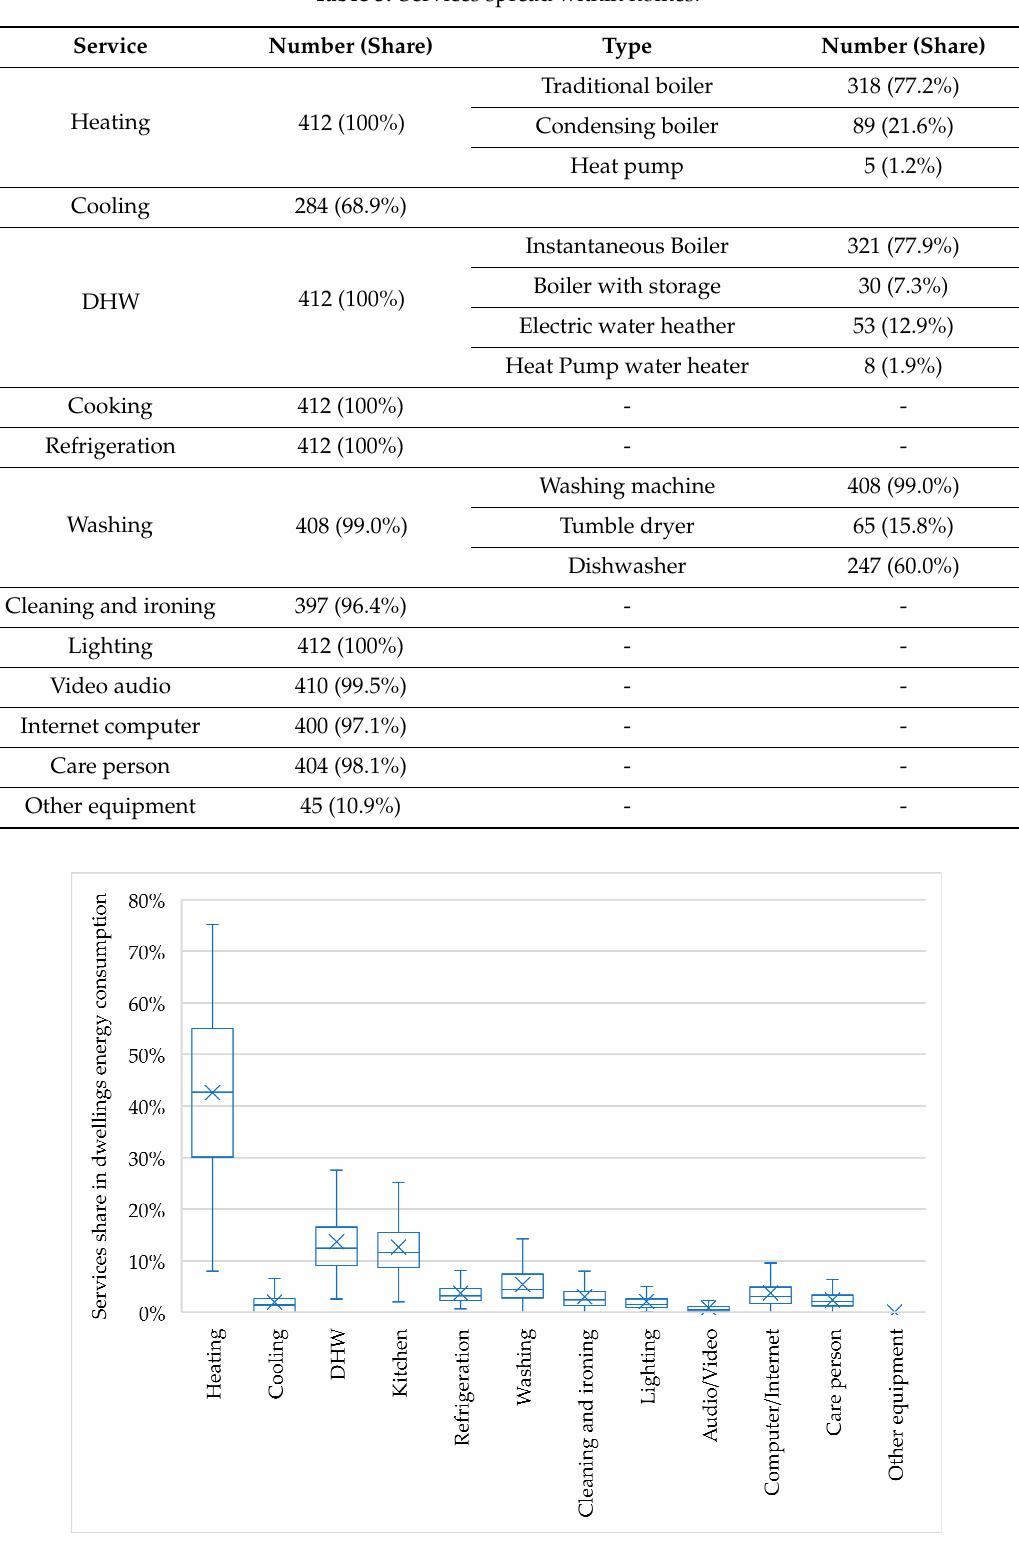
Figure 8. Average values of services share in dwellings energy consumption. Heating 43.5%